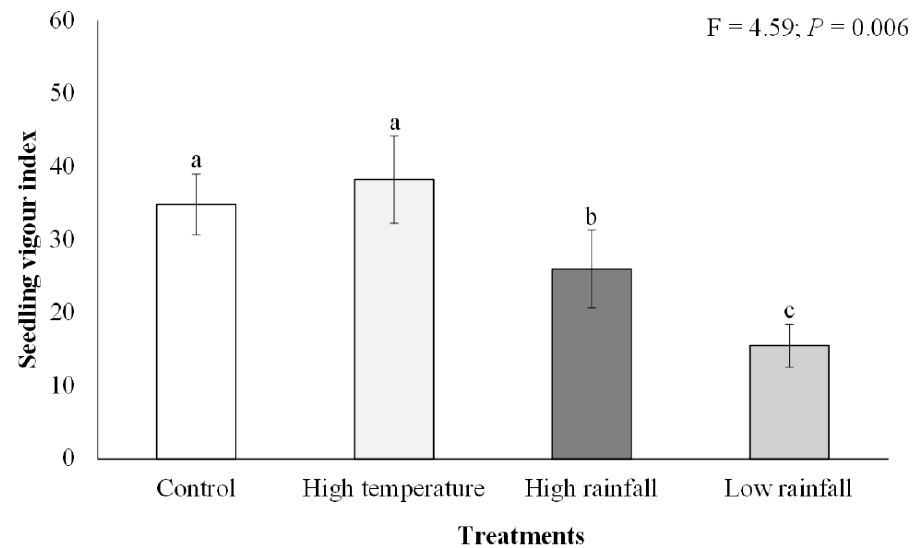
Figure 2. Effects of elevated temperature and high and low rainfall on Acacia mearnsii seedling vigour index II. Bars are means ± SE and one-way ANOVA results are shown. Bars with different letter superscripts are significantly different.